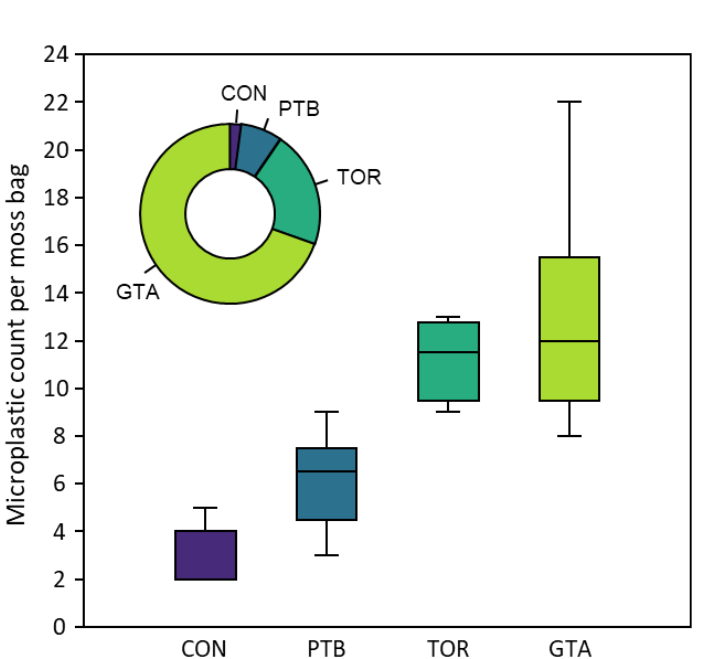
different. Further, microplastic counts for all groups were significantly different (higher) compared with the unexposed (control) bags (see Figure 2). The atmospheric deposition of microplastics within each group was estimated to be 21 mp m −2 day −1 in PTB, 50 mp m −2